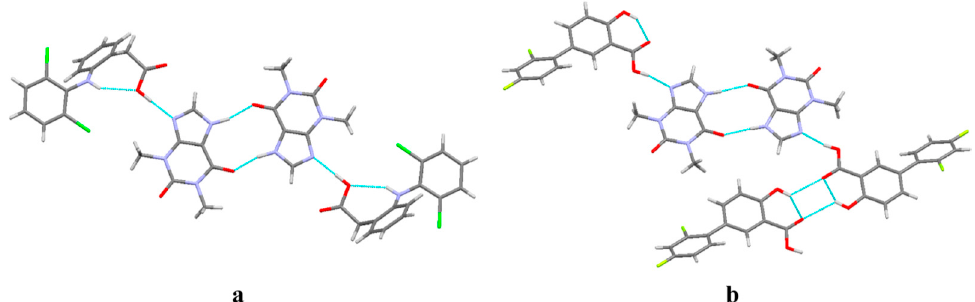
Figure 25. Hydrogen bond synthon present in ( a ) diclofenac–theophylline and ( b ) diflunisal-theophylline cocrystal. Adapted with permission from Mol. Pharmaceutics , 2014, 11 (10), 3707–3715. Copyright 2014, American Chemical Society.